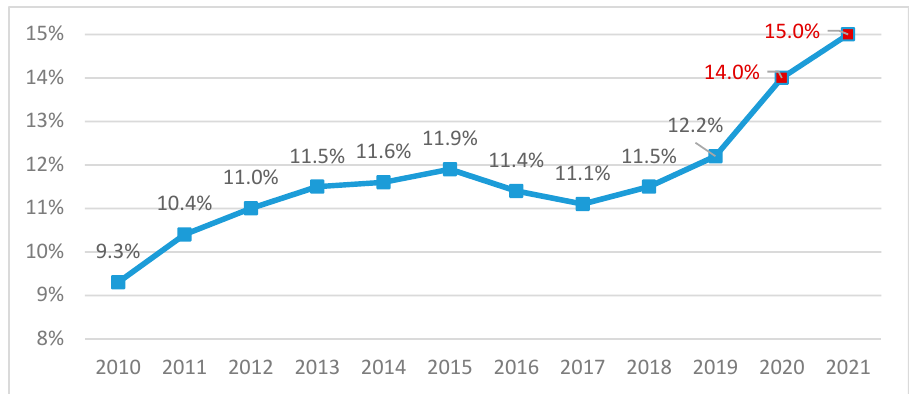
Figure 4. Share of RES in gross final energy consumption in Poland.